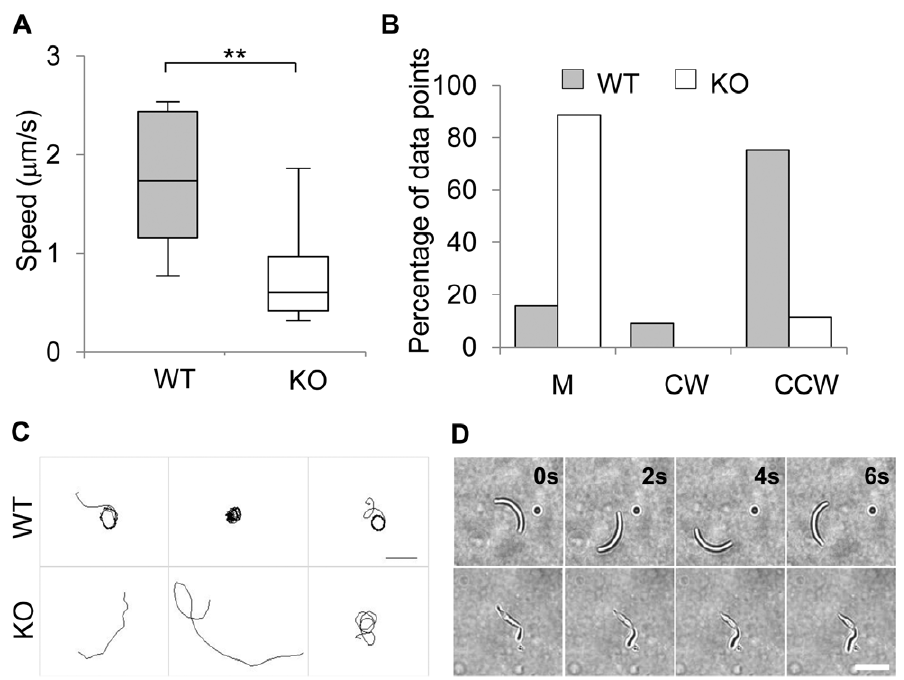
Figure 5. Characteristics of sporozoite motility in Matrigel. A. Speed of WT (n=15) and IMC1h-KO (n=11) sporozoites. B. Results of the manual assignment of movement patterns of WT (n=15) and IMC1h-KO (n=11) sporozoites. M=Meandering, CW=clock-wise, and CCW=counter clock-wise. C. Reconstruction of tracked sporozoite paths from high-magnification movies revealing movement patterns (two frames per second for 100 s). WT sporozoites (upper panel) mainly display a circular mode of motility while IMC1h-KO sporozoites (lower panel) mainly show a meandering mode of motility. Scale bar=20 m m. D. Brightfield time-lapse image sequences showing motile WT and IMC1h-KO sporozoites. Scale bar=10 m m. doi:10.1371/journal.pone.0041409.g005 PLoS ONE |